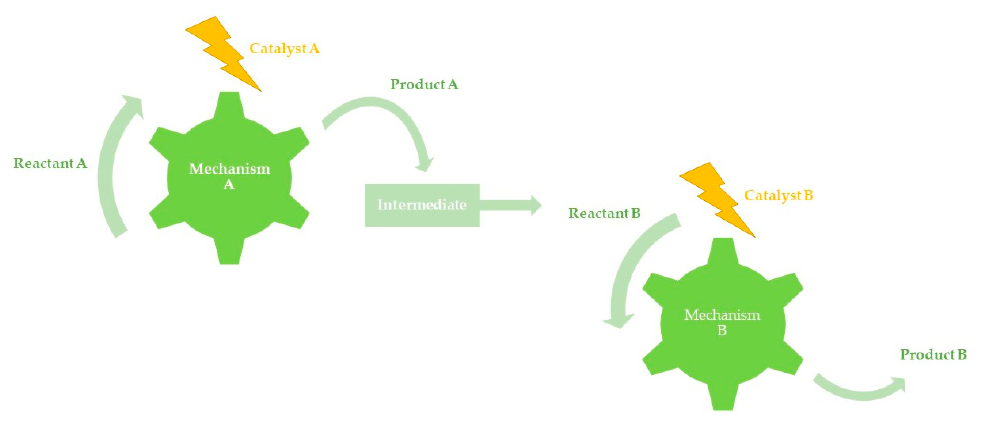
Figure 2. Schematic illustration of orthogonal tandem